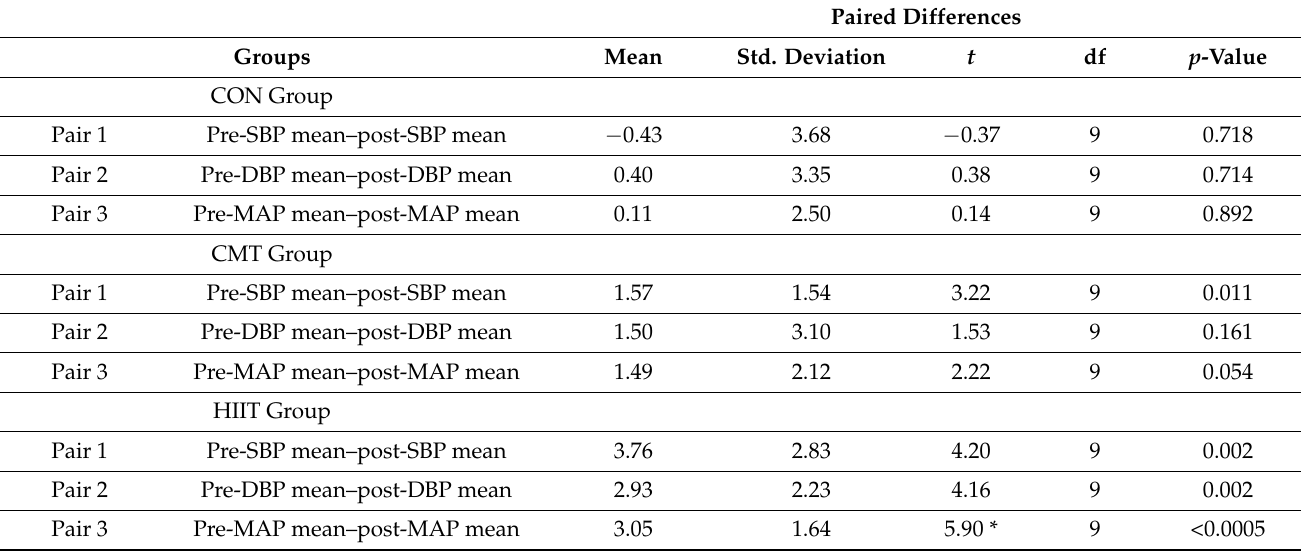
Table 3. Paired sample t-tests for SBP, DBP and MAP among the 3 groups.